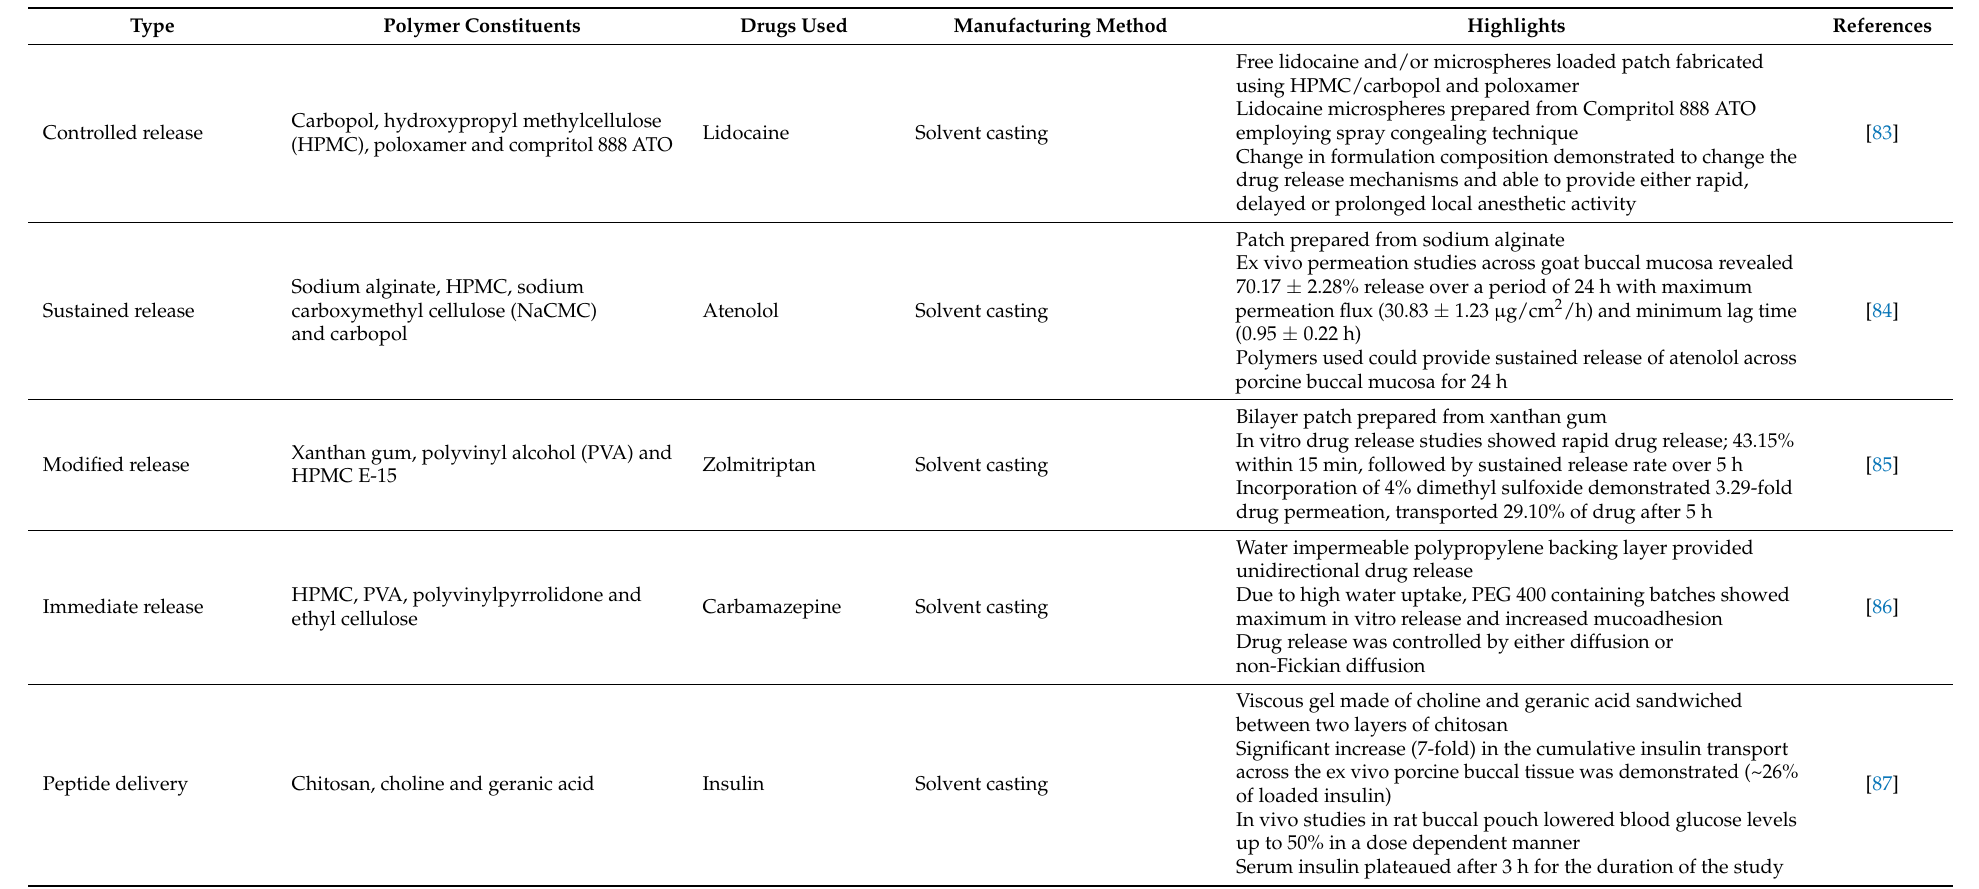
Table 2. Examples of mucoadhesive buccal patches and their